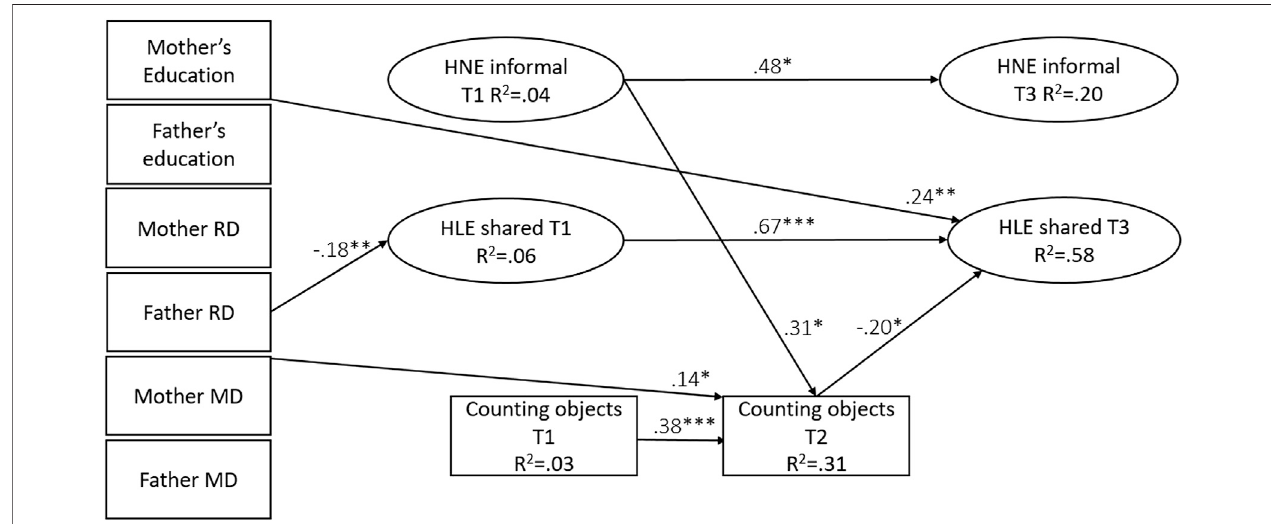
FIGURE 4 | The model for counting objects skill with signi fi cant standardized estimates. Note: In addition to the regression paths depicted, there were two signi fi cant residual correlations: between HNE and HLE at T1 (stand. estimate (cid:1) 0.38***) and between HNE and counting objects at T1 (stand. estimate (cid:1) 0.31**).